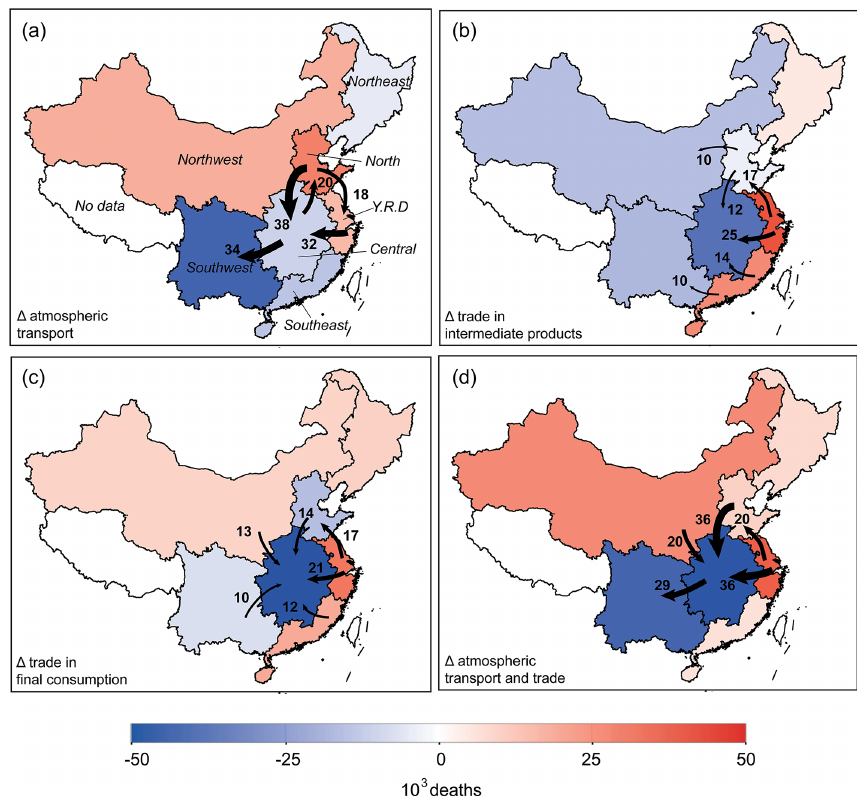
Figure 3. The effect of atmospheric transport (a) and trade (b–d) on each region’s PM 2 . 5 -related premature deaths. Panel (a) compares the number of premature mortality related to emissions produced in each region and deaths that occurred in that region. Panel (b) and (c) compare regional production-related premature deaths with deaths related to production of final goods in that region, and deaths related to consumption of goods and services in that region, respectively. Panel (d) compares the number of premature deaths occurred in each region with deaths related to consumption of goods and services in that region. Deaths in other regions due to Chinese pollution and deaths due to emissions in other nations are not included in any of the maps, and international export on regional premature deaths are not included in map (c) and (d) . Arrows between regions denote the largest interregional transfers, with numbers of displaced premature deaths shown in